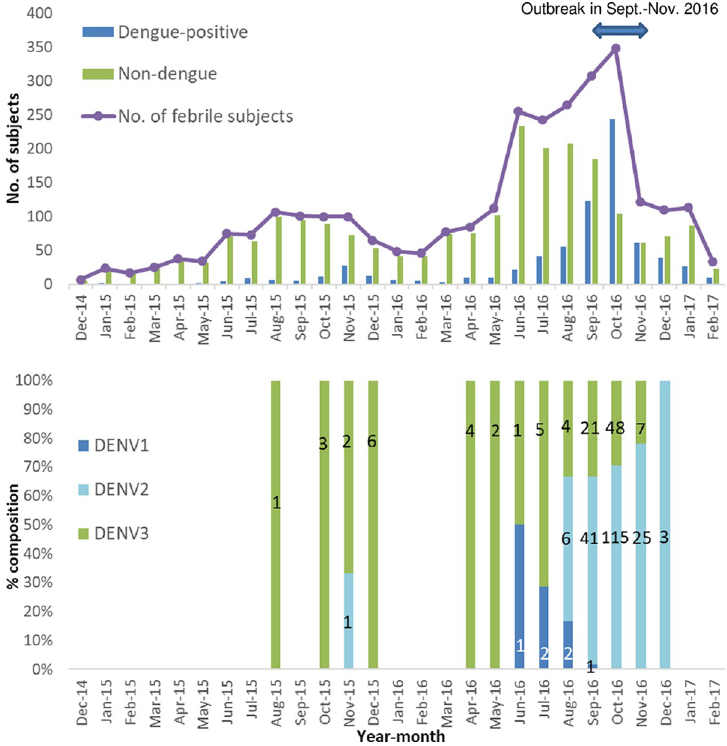
Fig 4. Monthly distribution of febrile enrollees, dengue-positive and non-dengue cases & monthly distribution of dengue serotypes � in PCR-positive cases. The figure has two parts: the upper part shows monthly distribution of dengue-positive and non-dengue cases among the enrolled patients; and the lower part shows distribution of serotypes identified (numbers shown in the bars) by month. � number of identified serotypes shown in the bars.